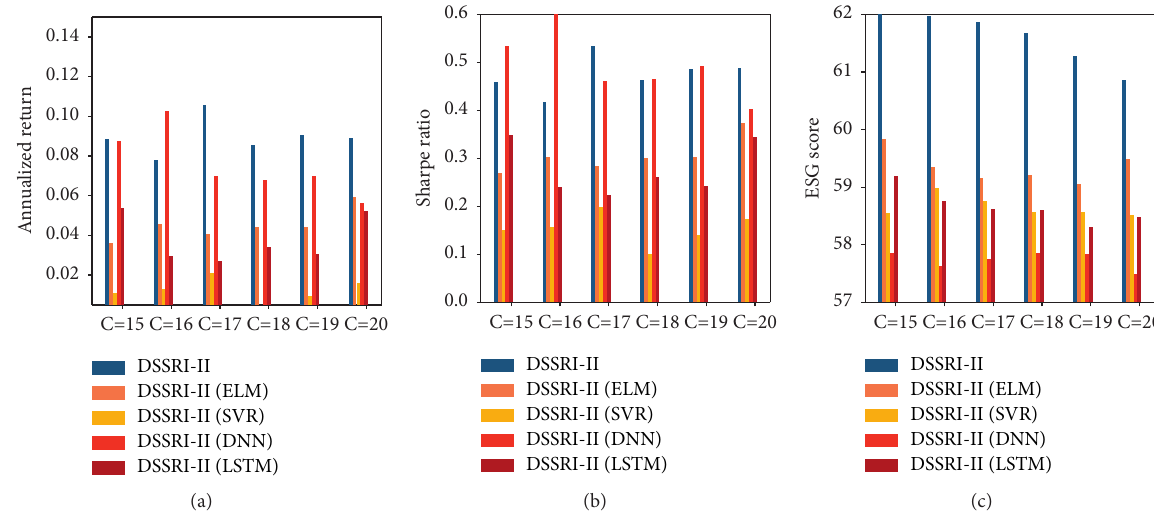
Figure 5: Performance of the DSSRI-II model and the DSSRI-II model (based on other machine learning models) at different portfolio cardinalities.